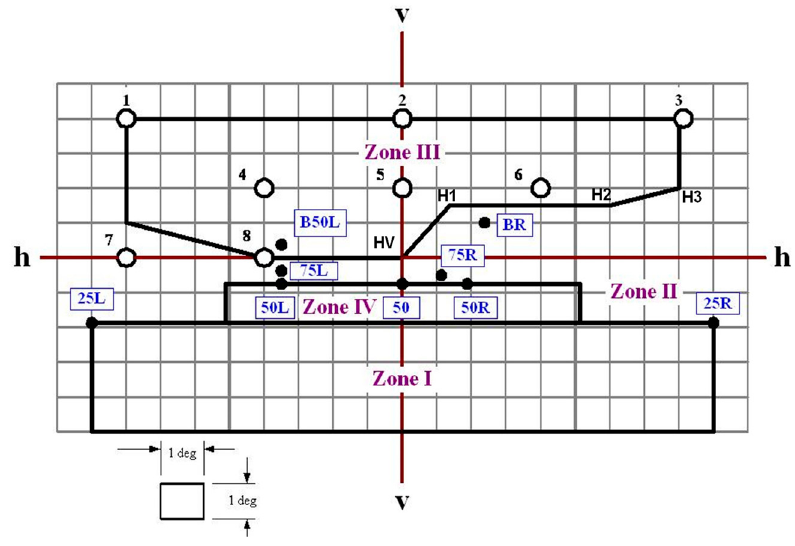
Figure 1. Illustration of test points and zones on the projection screen for inspecting the right-hand traffic passing beam. Table 1. Luminous intensities at the test points and zones required for the right-hand traffic pass- ing